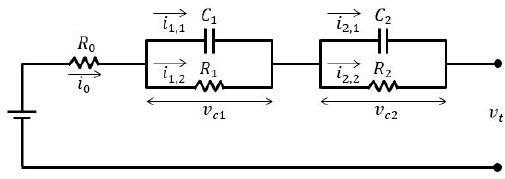
Figure 1. Two ladder battery ECM.